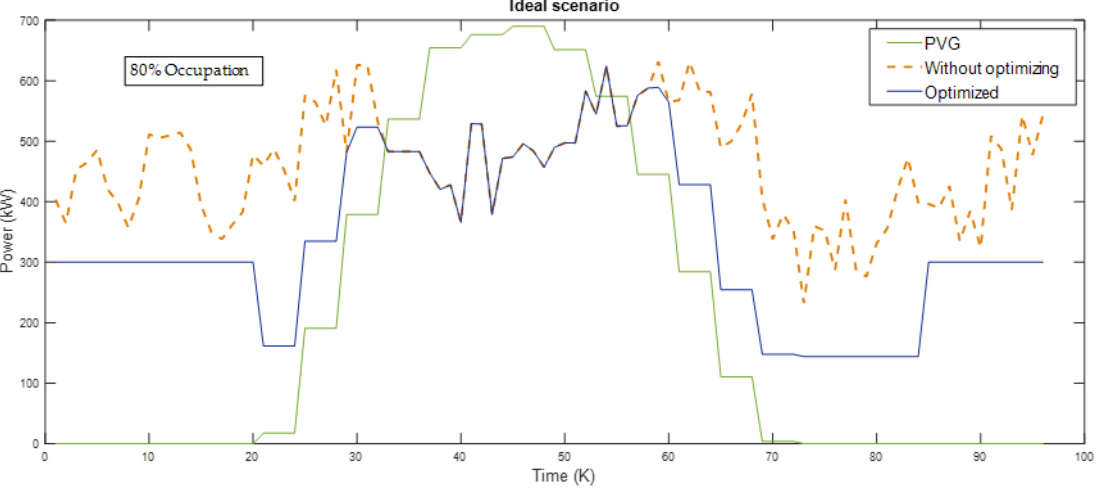
Figure 17. Demand optimization in the 80% scenario (real and ideal load